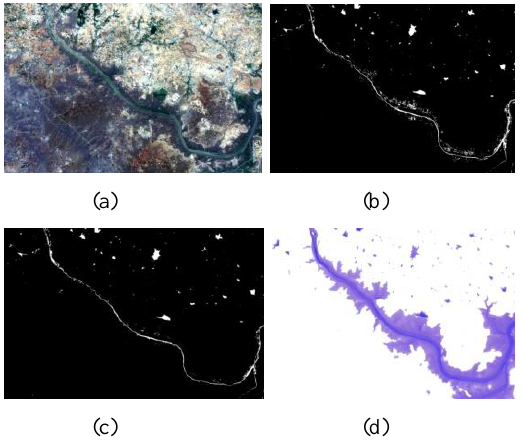
Figure 14: (a) Sub scenes of Scene-2 (b)proposed method: river bank with wet soil (c) river bank removed wet soil (≤ 0.03) (d) Reference image of